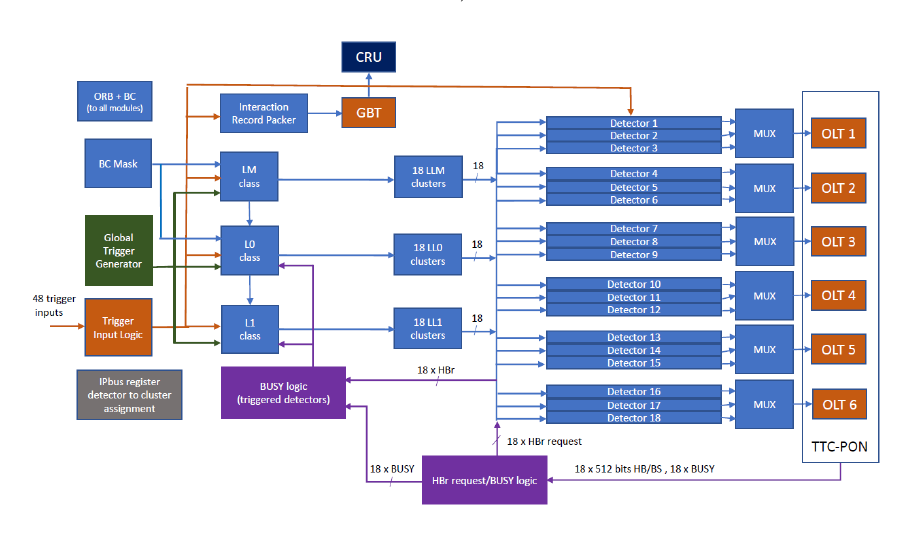
Figure 4. Main elements on the CTP FPGA